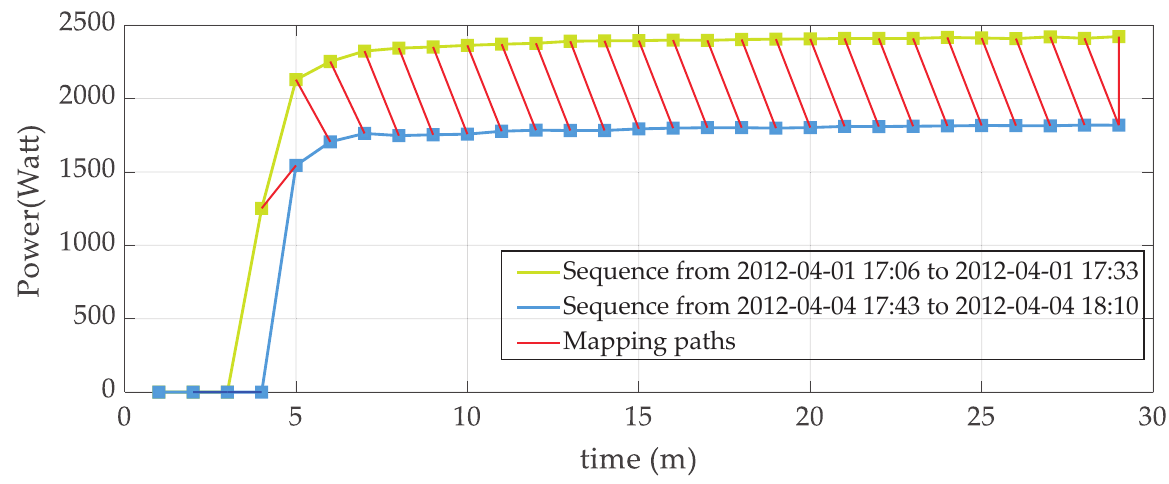
Figure 1. Demonstrative mapping paths in DTW distance calculation for two typical power